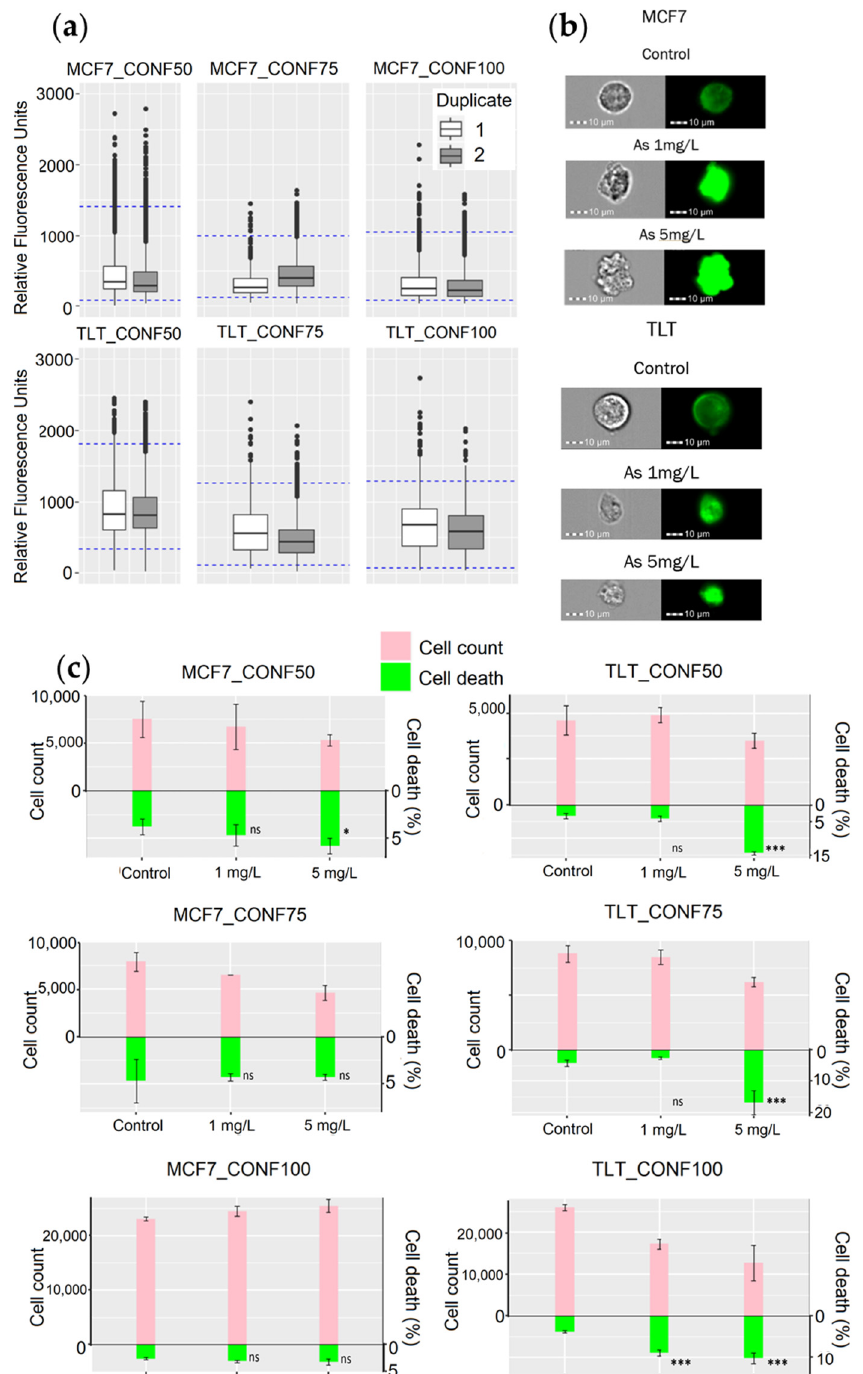
Figure 8. Evaluation of the performance of the MPCVA method for toxicity assessment. ( a ) FV intensity values of the untreated cells (control) measured with the MPCVA method and shown as box plots. The blue dashed lines represent the viable FV intensity ranges of each group of replicates separately. ( b ) The representative images (brightfield and FITC/GFP channel) of MCF7 and TLT cells in MIFC analysis. ( c ) Comparison of the MPCVA method with the cell count method. The top bars (pink) represent the cell number measured by the cell count method. The green bars represent the percentage of cell death measured using the MPCVA method. Samples with a higher percentage of dead cells should have lower cell viabilities after 24 h (cell counting) and vice versa. Cell death % of treated and control (untreated) samples was statistically compared using the Chi-squared method (ns > 0.05, * 0.05, , *** 0.001) (labeled below).